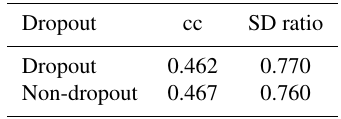
Table B6. Example values with and without dropout layers hav- ing been conditioned, with the rest of the parameters fixed as in Table B1.